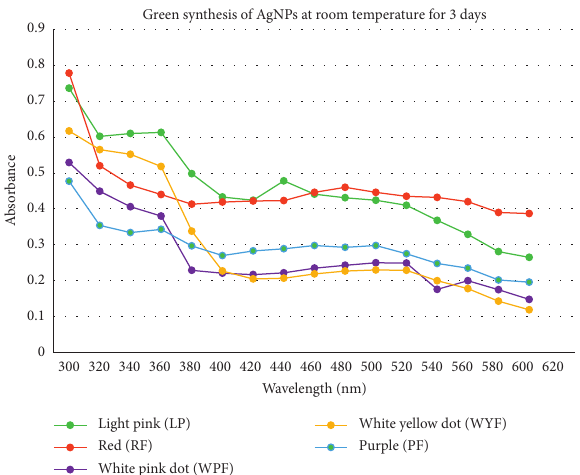
Figure 9: UV-Visible spectra of the synthesized AgNPs.